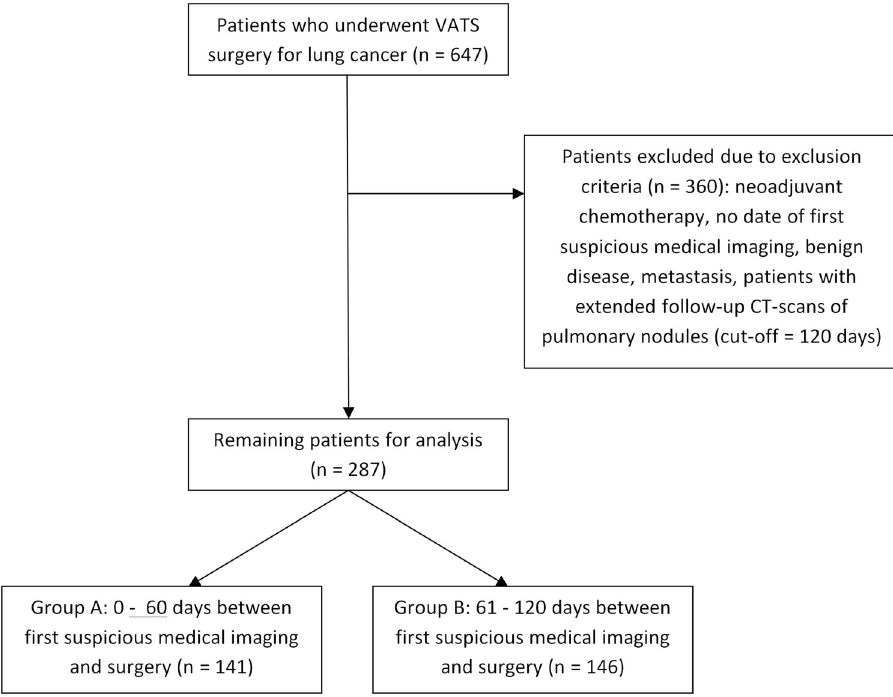
Figure 1. CONSORT diagram of patient selection for statistical